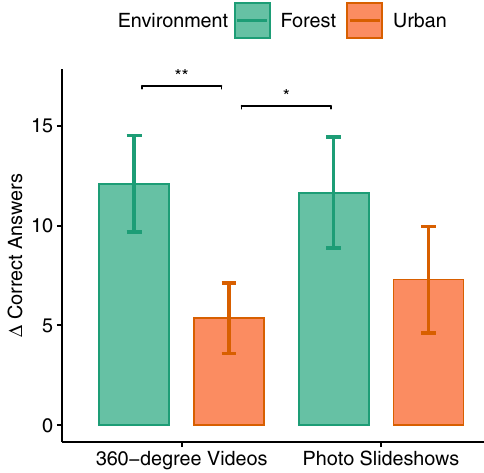
Figure 9. Difference scores of the cognitive test consecutive correct answers.